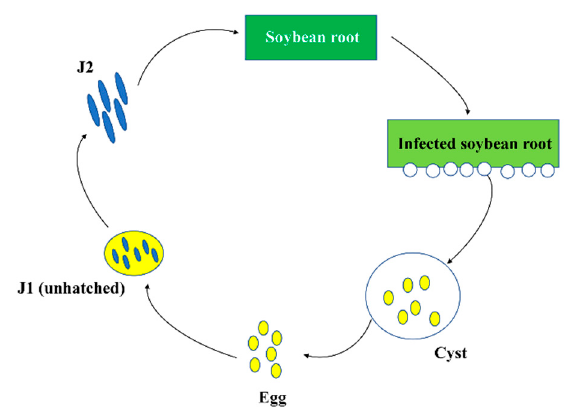
Figure 3. Infection cycle of Heterodera glycines .